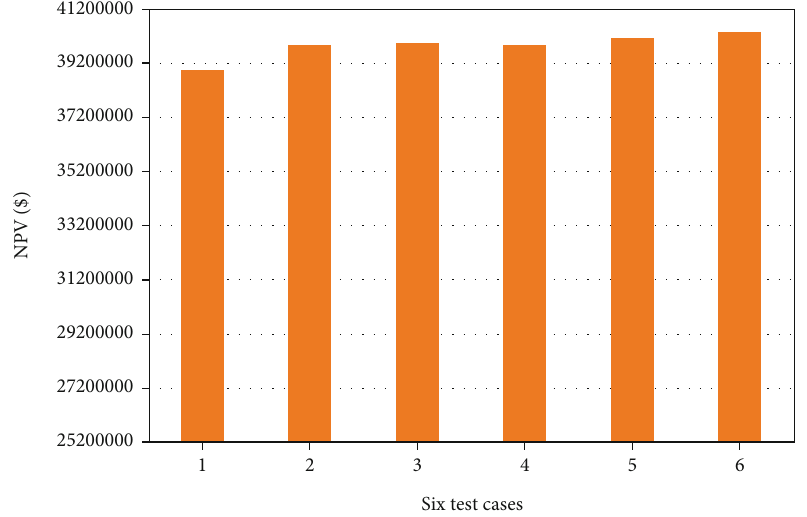
Figure 14: The maximum NPV after 50 iterations for di ff erent